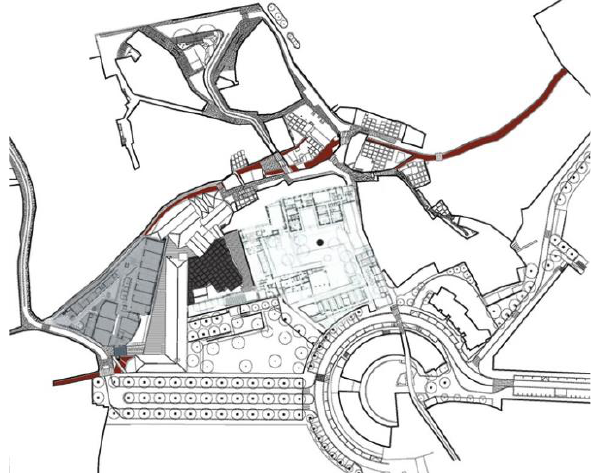
Figure 17. General location plan, Currently Centre for Advanced Post-graduate Formation, Universidad do Minho and Multifunctional Couros Complex, with the river Couros shown in red, Guimarâes, Portugal. Design Group of architects Pitagoras. Source: Pitagoras